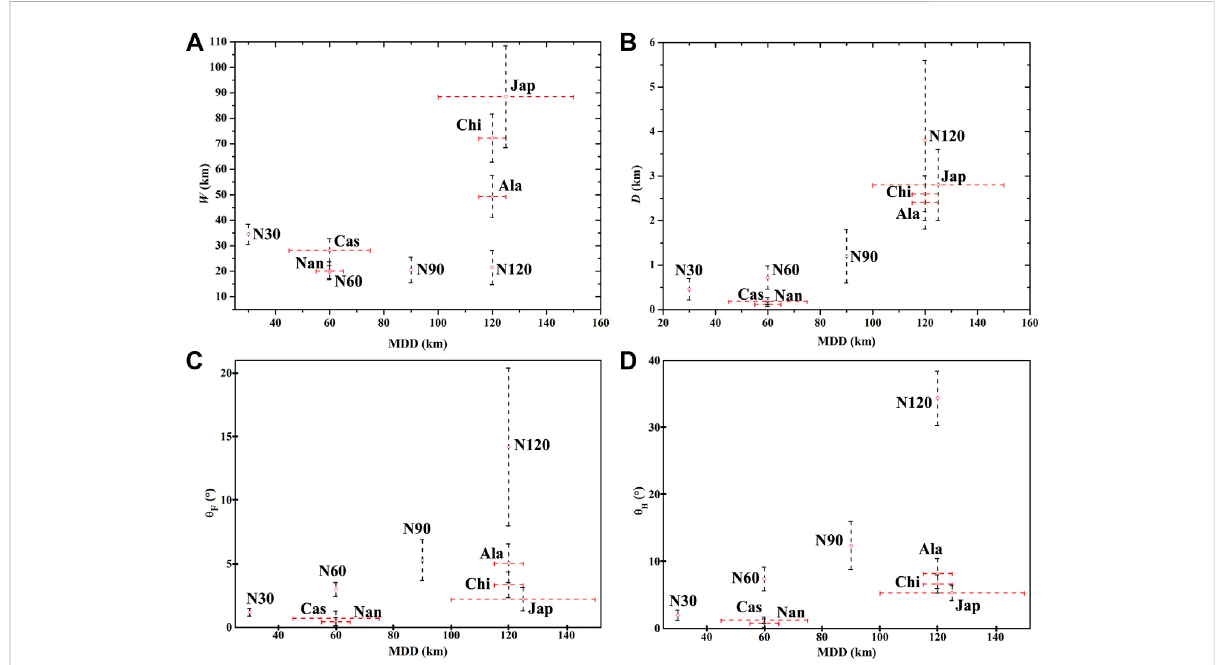
FIGURE 11 (A – D) Comparison of the trench parameters: (A) W , (B) D , (C) θ F , and (D) θ H of selected natural subduction zones with the model results for varying maximum depth ofdecoupling(MDD). N30, N60, N90, and N120points represent numerical experimentresults with 30, 60, 90,and 120 km MDD values, respectively. Subduction zone abbreviations: Cascadia-Cas; Nankai-Nan; Chile-Chi; Alaska-Ala; Japan-Jap.